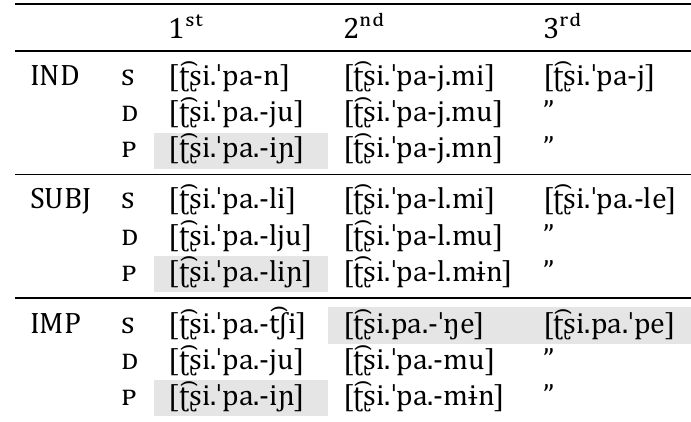
Table 9: Verbal paradigm for vowel-(cid:976)inal root [ʈ͡ʂipa-] ‘exit’, after Havestadt 1777 and Febrés 1765 (forms contradicting the ‘general rule’